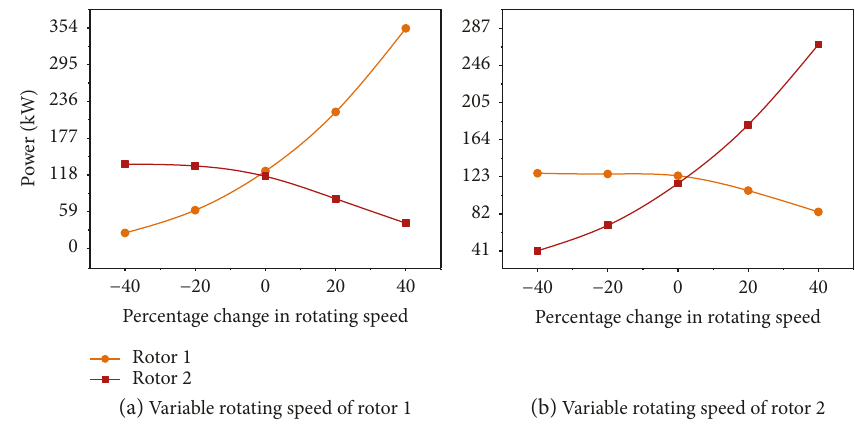
Figure 11: Shaft power characteristic lines of two-stage rotors under variable rotating speed.